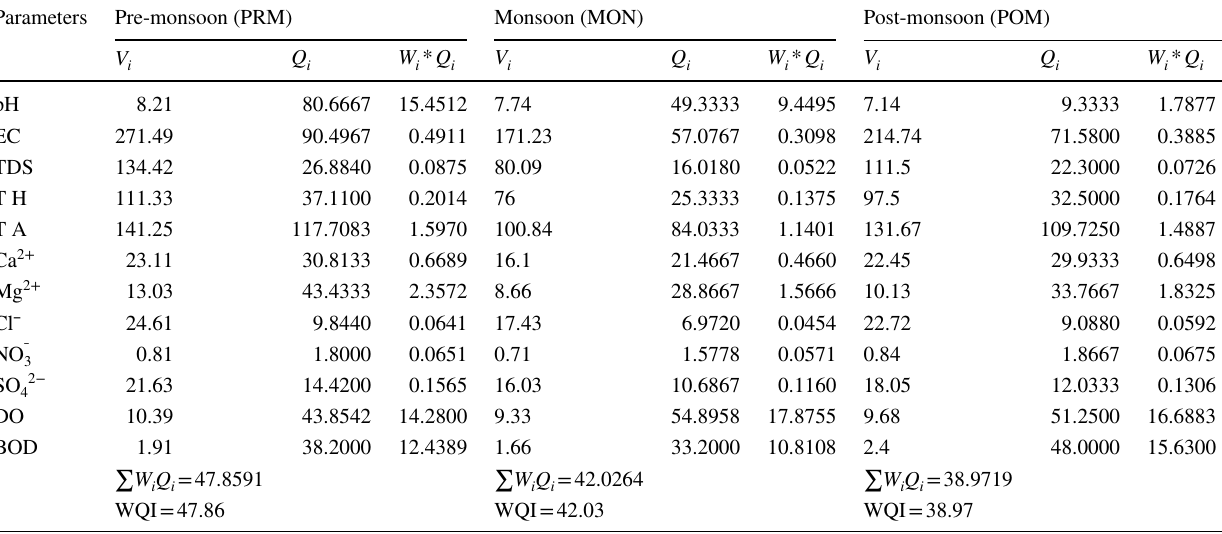
Table 5 Calculation of WQI at station 1 (S 1) Parameters Pre-monsoon